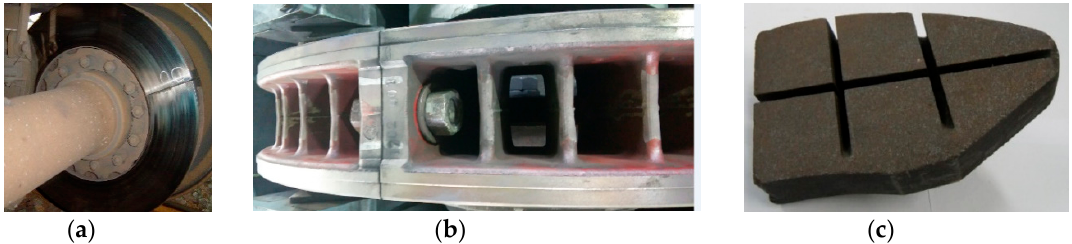
Figure 1. Brake dynamometer. 1-D.C. motor, 2-bearing, 3-Inertial wheel, 4-Tread brake, 5-air cylinder, 6-brake disc, 7-pad, 8-control box. ( a ) Schematic diagram; ( b ) Photograph.